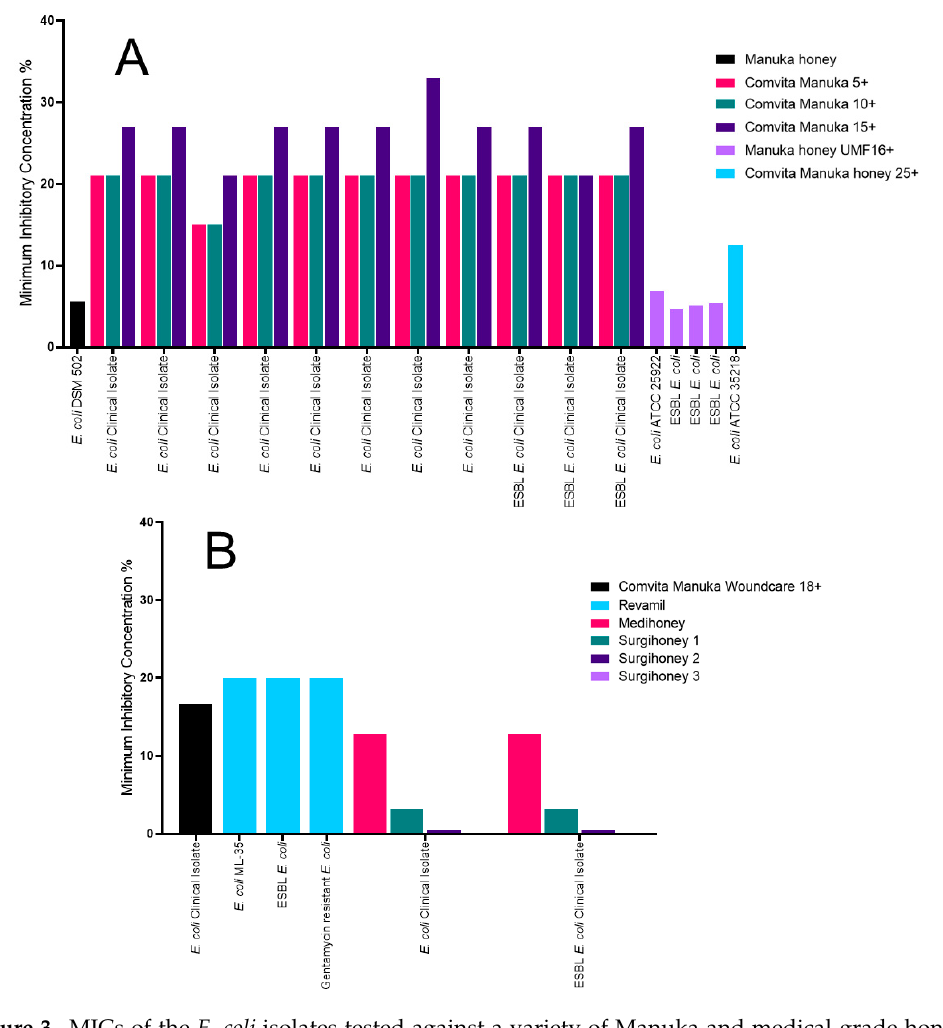
Figure 3. MICs of the E. coli isolates tested against a variety of Manuka and medical-grade honey. ( A ) All the Manuka honey MIC data used in this review, identifying an ungraded Manuka honey and Manuka honey UMF16+ as the most effective; and ( B ) all the medical-grade honey MIC data used in this review, identifying the three Surgihoneys as the most effective.